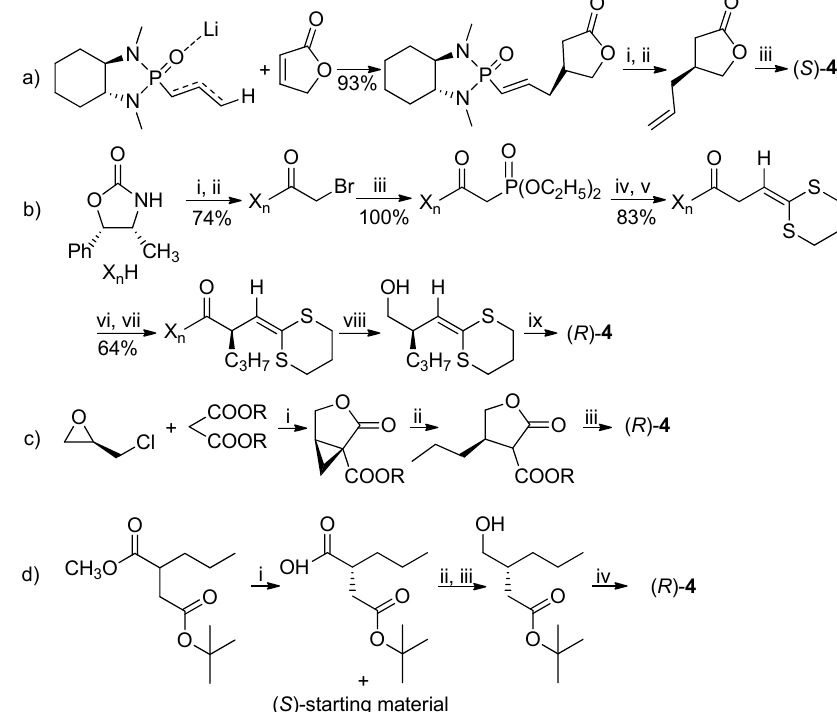
Figure 1. Structures of brivaracetam and related